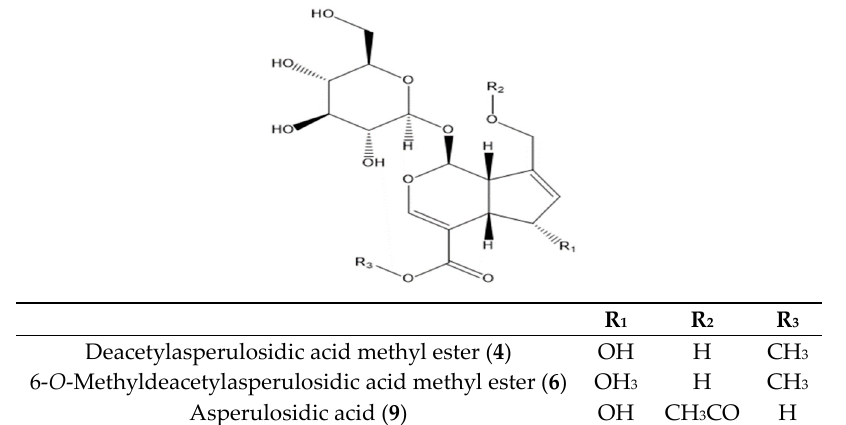
Figure 1. Structures of compounds 1 - 10. Table 1. Identification of compounds 1 - 10 in H. diffusa via UPLC-ESI/LTQ-Orbitrap-HRMS analysis.